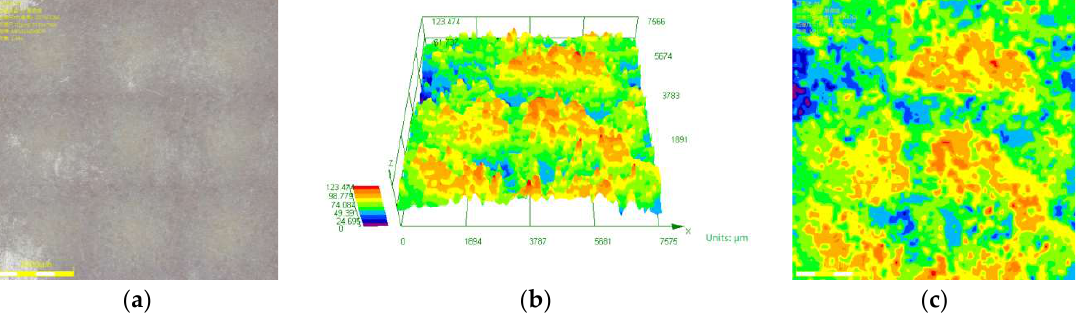
Figure 8. Corrosion depth analysis of the sample corroded in 30% crude oil/brine at the well depth of 800 m: ( a ) corrosion morphology, ( b ) 3D diagram of corrosion depth distribution, and ( c ) contour diagram of corrosion depth distribution.